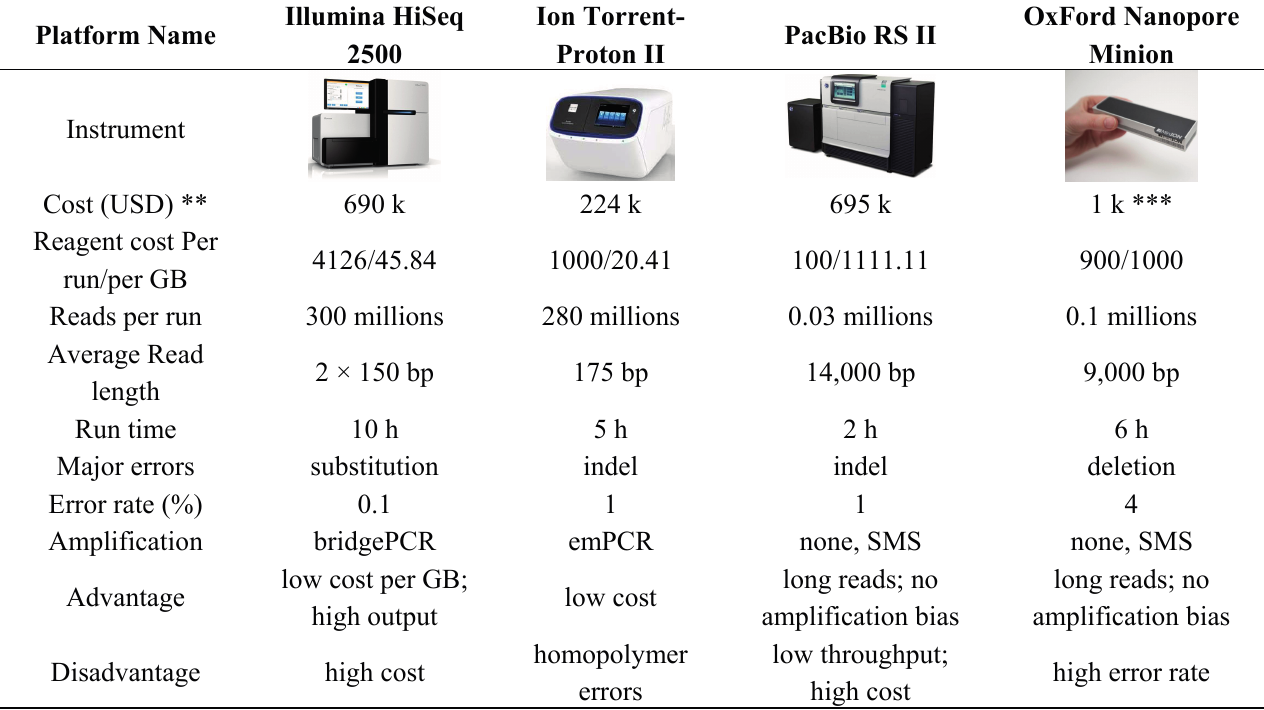
Table 1. The most frequently used NGS platforms *.